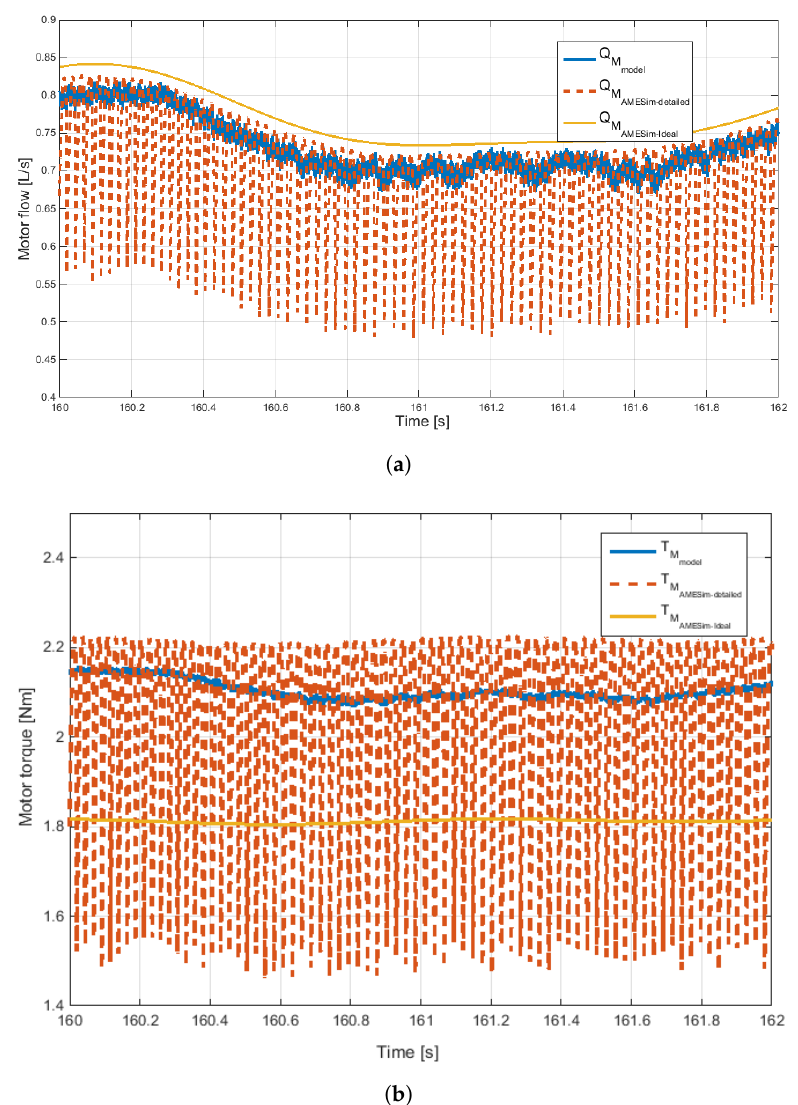
Figure 18. Flow ( a ) and torque ( b ) in the hydraulic motor for the mathematical model presented in Section 2.4, and the detailed and ideal models implemented in